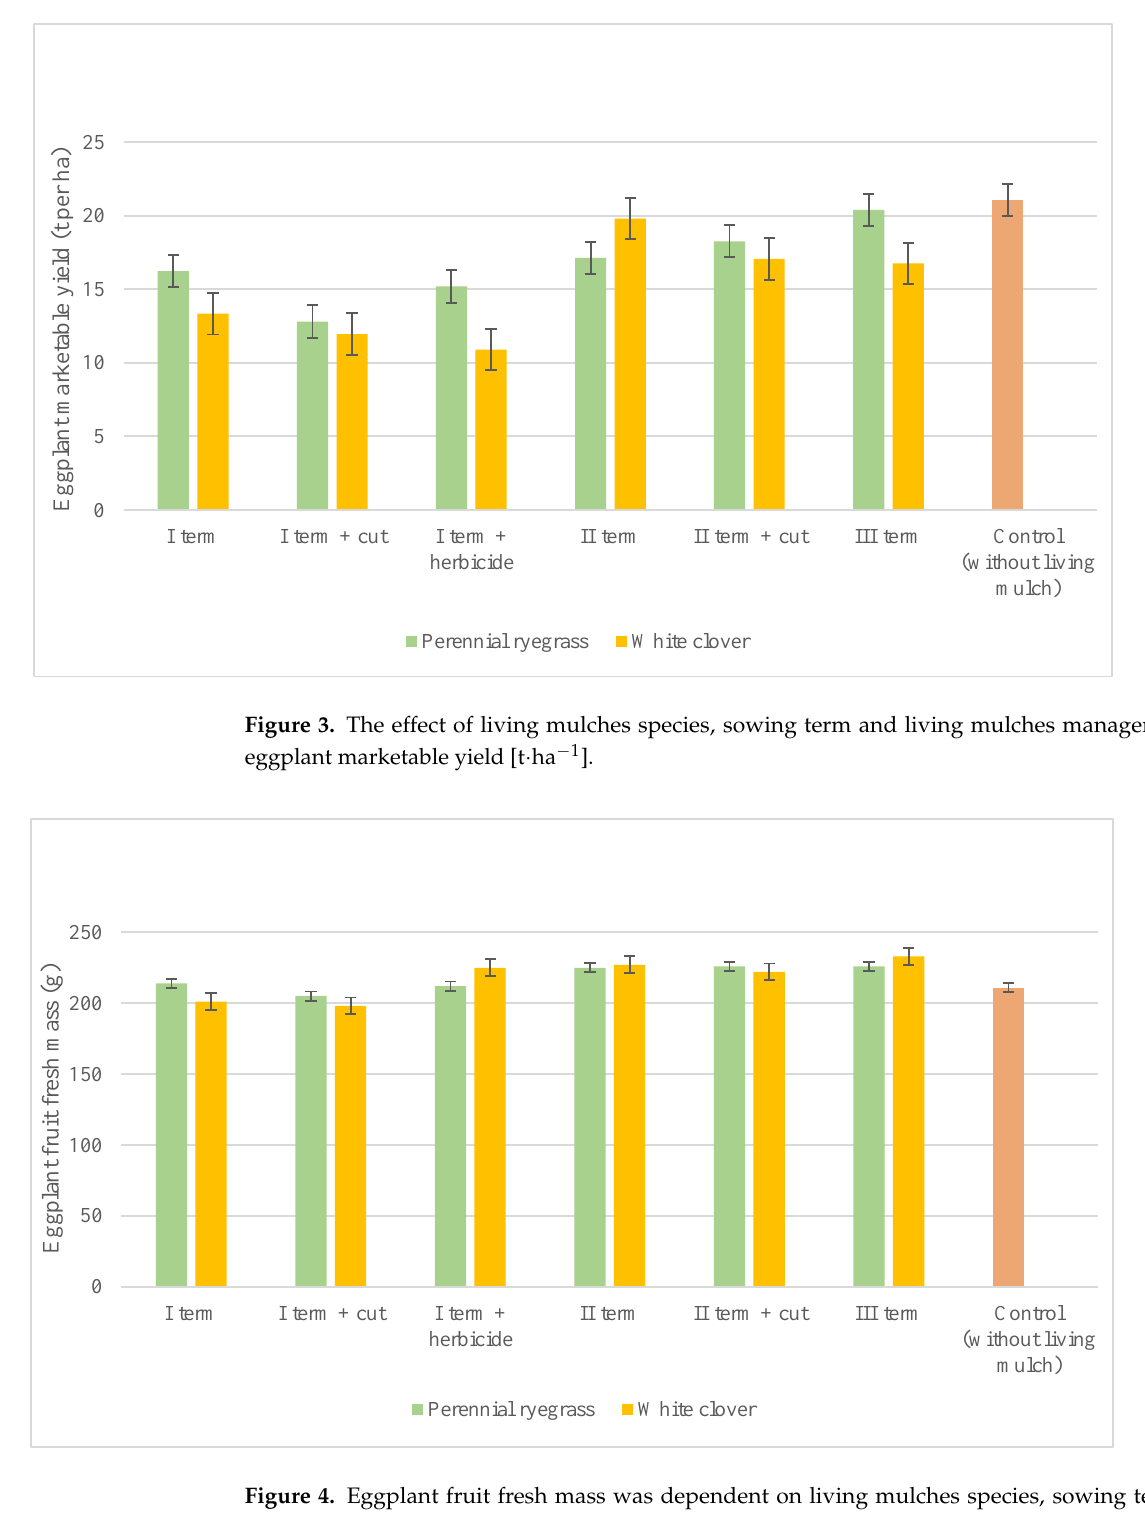
Figure 4. Eggplant fruit fresh mass was dependent on living mulches species, sowing term and management